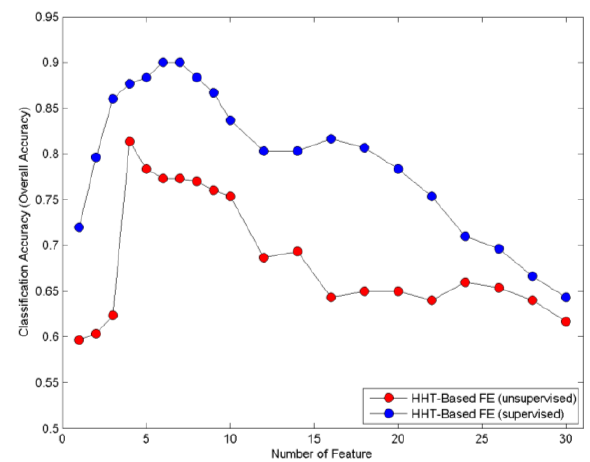
Figure 3. Comparison of classification accuracies between HHT-based